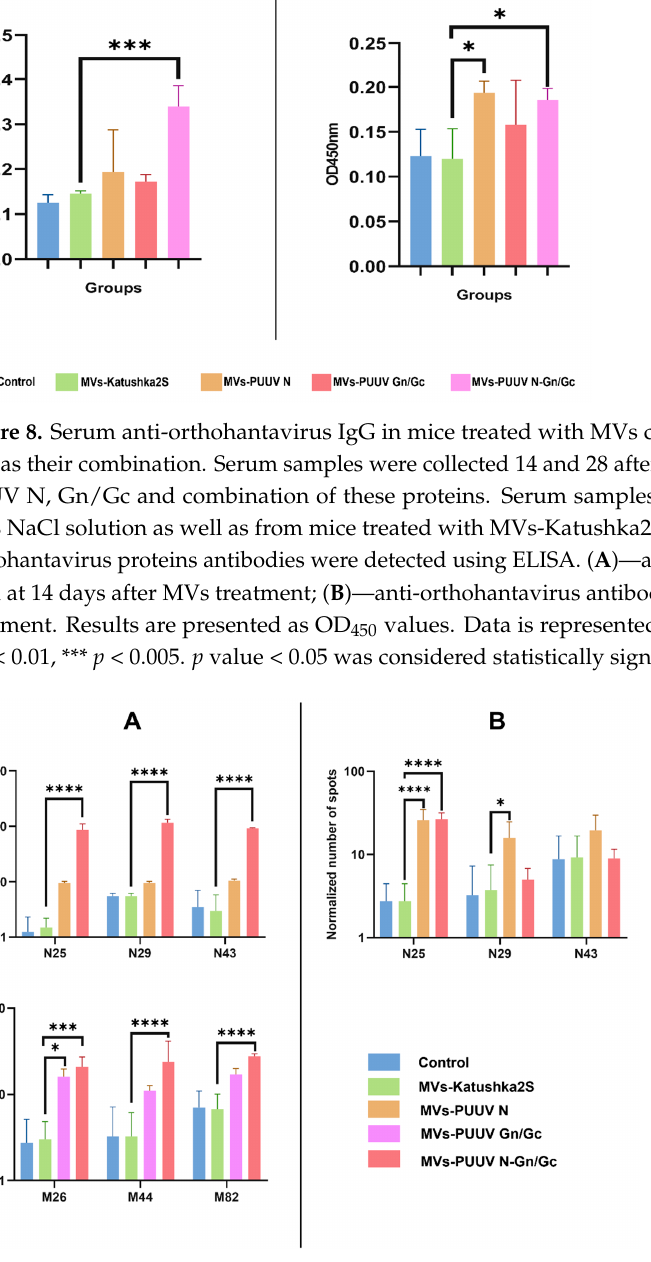
Figure 9. Analysis cytotoxic T lymphocytes at 14 and 28 days after MVs injection. ELISpot method was used for detection of INF- γ secretion by the activated T cells. Mice lymphocytes were isolated after treatment with MVs containing PUUV N, Gn/Gc, or their combination. Control lymphocytes were obtained from mice treated with 0.9% NaCl solution as well as from mice treated with MVs-Katushka2S. Lymphocytes (1 × 10 5 cells) were placed into each well and treated with 1 µg of PUUV N25, N29, N43, M26, M44 or M82 peptides. Number of spots was counted to demonstrate the cytotoxic T cells activation. ( A )—Cytotoxic T cell activation 14 days after MVs treatment; ( B )—Cytotoxic T cell activation at 28 days after MVs treatment. Data is represented as median ± SD. * p < 0.05, ** p < 0.01, *** p < 0.005, **** p < 0.0001 . A p -value < 0.05 was considered statistically sig- nificant.